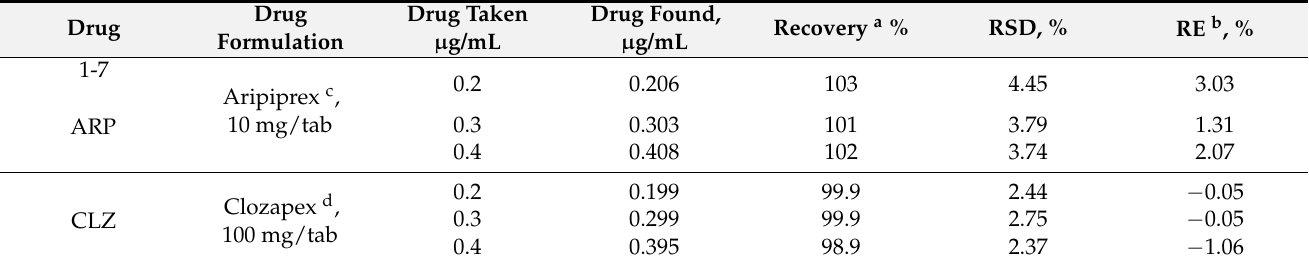
Table 4. Recovery of the studied drugs from their pharmaceuticals using the proposed spectrofluoro- metric